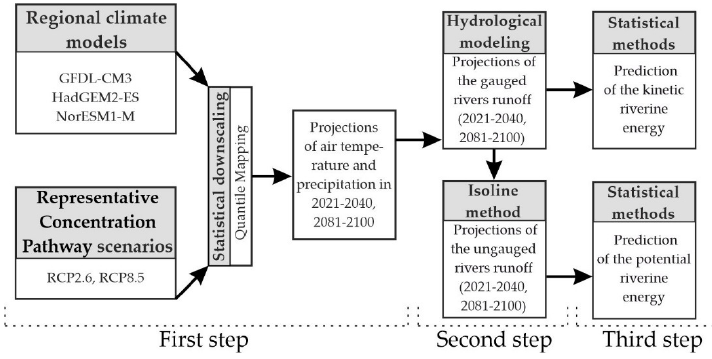
Figure 2. Principal scheme of the study.